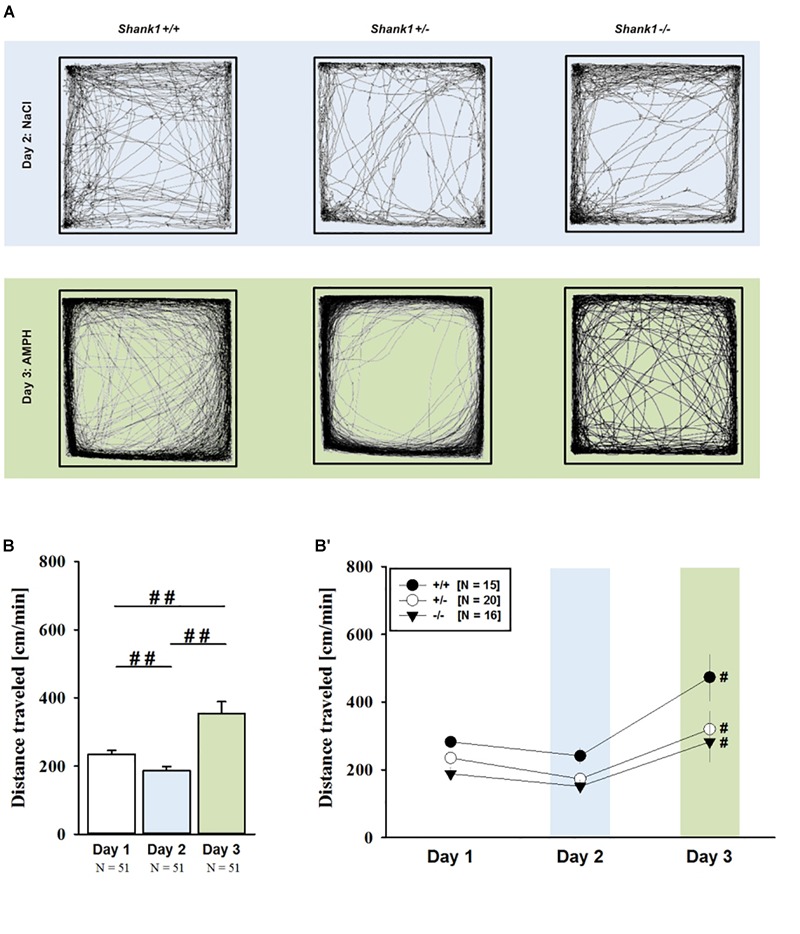
AMPH-induced hyperactivity in juvenile Shank1 mice. (A) Exemplary figure depicting the locomotor activity pattern of individual juvenile Shank1+/+, Shank1+/-, and Shank1-/- mice injected with saline (NaCl) on day 2 (upper panel) and with AMPH on day 3 (lower panel); measured over 45 min. (B) Bar graph depicting the distance traveled by all genotypes during baseline testing (white bar), following saline administration (blue bar), and after AMPH treatment (green bar). (B′) Line graph depicting the distance traveled by Shank1+/+ (black circle), Shank1+/- (white circle), and Shank1-/- (black triangle) over the three consecutive test days. Data are presented as means + SEM or means ± SEM. ##p < 0.001 (B), #p < 0.05 vs. day 2 (B′).